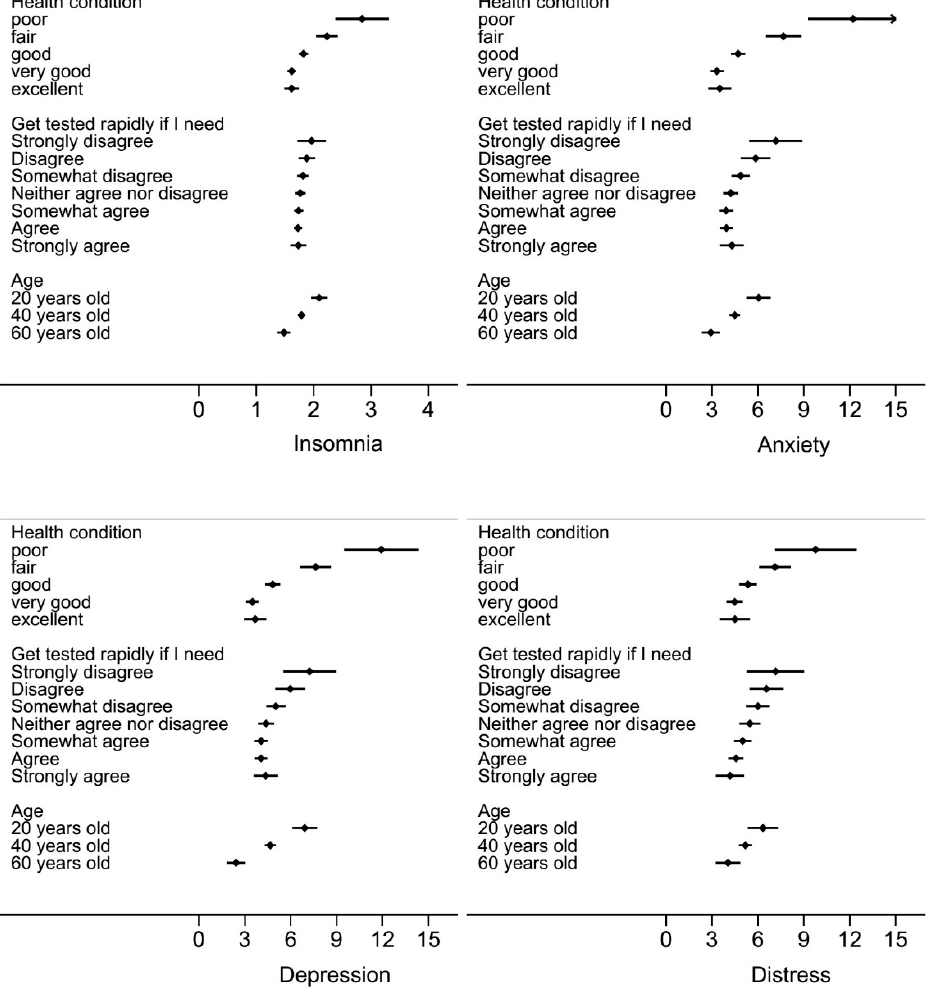
Figure 1. Predicted value and 95% confidence intervals (CIs) of insomnia, anxiety, depression, and distress scores by health condition, COVID-19 test availability, and age.